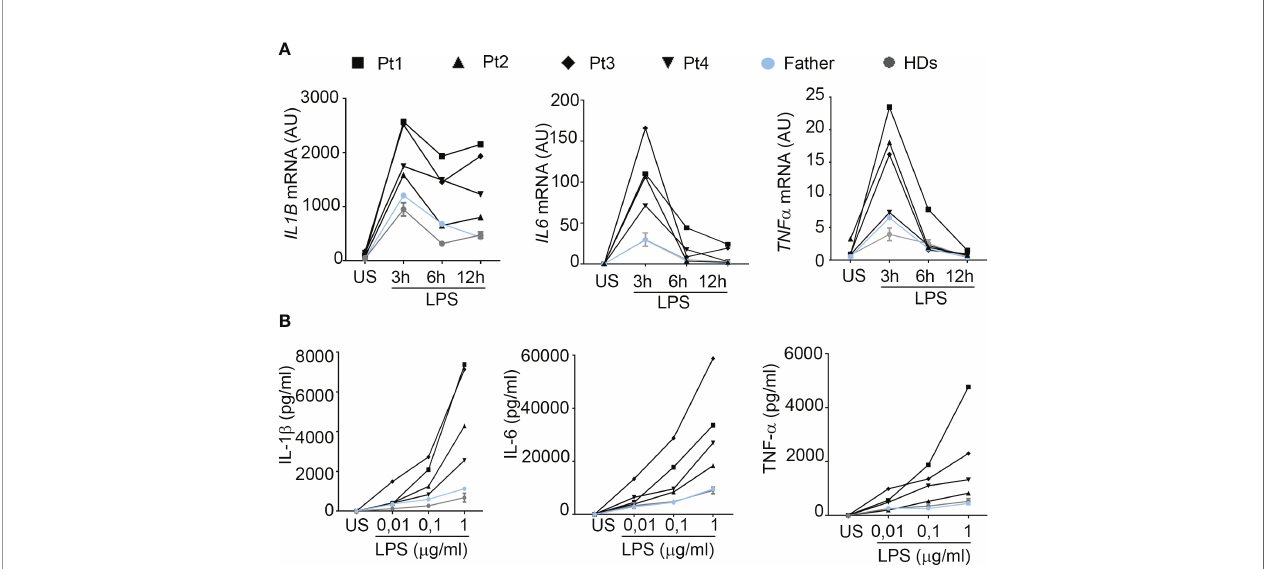
FIGURE 3 | PBMCs from HA20 patients express markedly higher levels of pro-in fl ammatory cytokines. (A) The mRNA expression levels of IL1B, IL6 and TNF were evaluated by qPCR analysis in PBMCs from patients (Pt1-4), a relative (father) and 2 healthy donors (HDs) unstimulated (US) or stimulated for the indicated hours h with 0.01 m g/ml of LPS. Results were obtained after normalization with the housekeeping gene HPRT1 and were expressed as arbitrary units (AU). (B) PBMCs isolated from patients (Pt1-4), a relative (father) and 4 healthy donors (HDs) were unstimulated (US) or stimulated for 24 hours with 0.01, 0.1 and 1 m g/ml of LPS and IL-1 b , IL-6 and TNF- a protein levels were measured in the conditioned media by